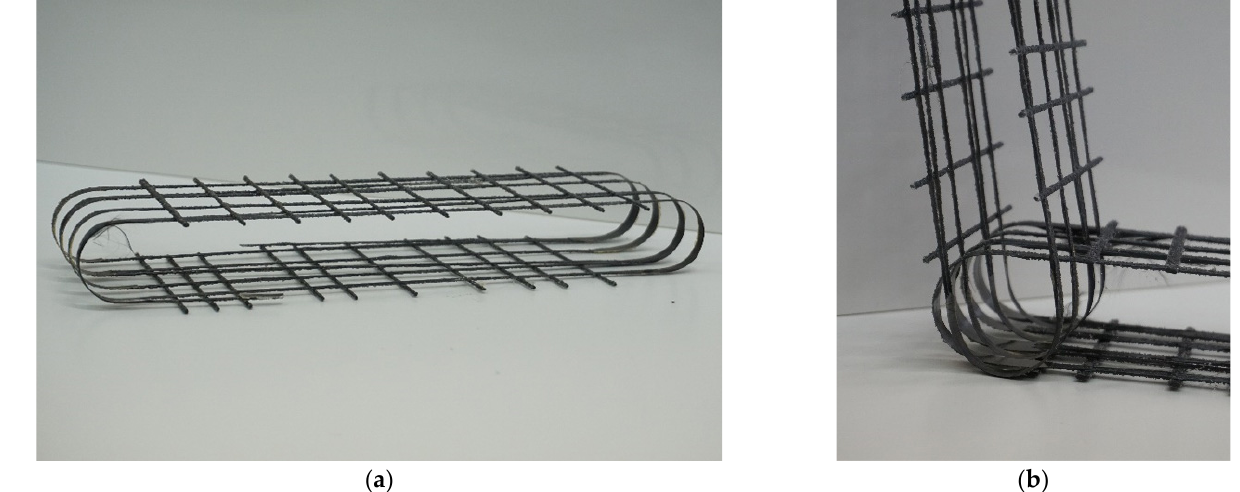
Figure 10. Rebar made of carbon roving ( a ) and detail presenting connection of rebars to form the reinforcement for the rigid frame ( b ).